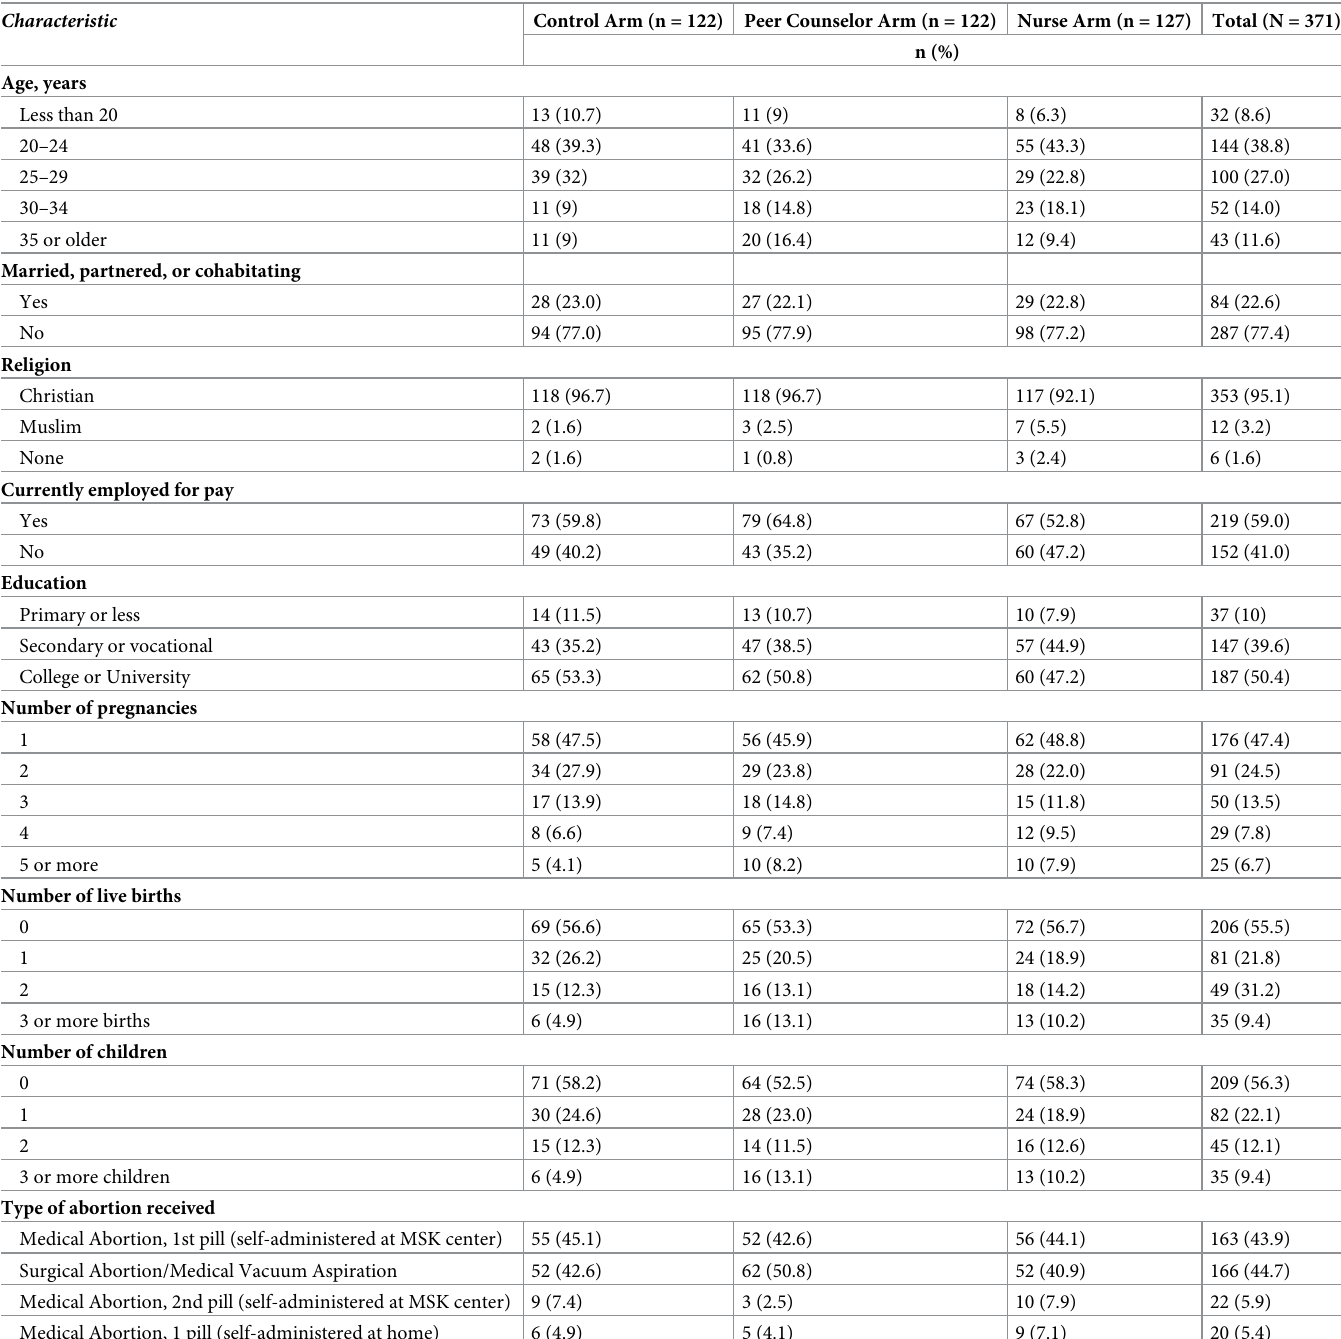
Table 1. Participant characteristics stratified by study